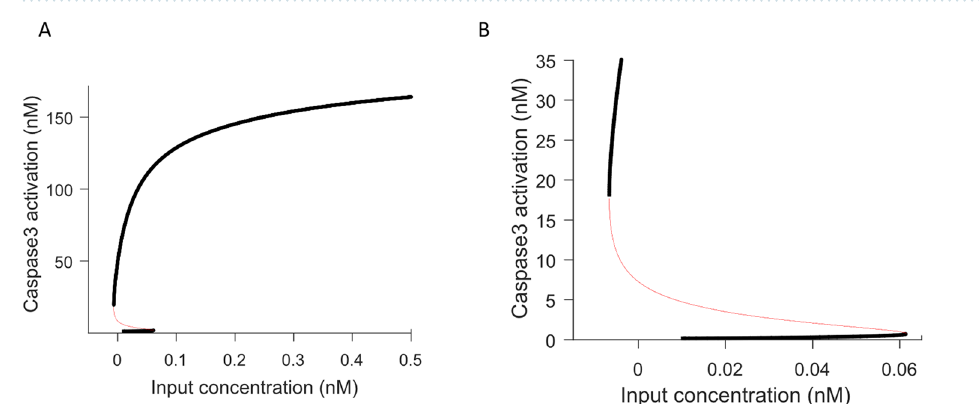
Figure 3. Bistable Behaviour of Caspase 3 activation. Steady state stimulus response bifurcation curve of caspase 3 activation. That simulated caspase 3(C3*) activation demonstrates irreversible bistability and hysteresis. ( A ). Three steady states are exhibited by the system, two stable (solid line) and one unstable (dashed line). The system can reside in one of the two stable steady states (‘on’ or ‘off’) but not in the intermediate unstable steady state. ( B ). The first bifurcation point at 0.06 and the second at − 0.01 indicates that the system displays hysteresis between stimulus concentration ( u ) 0–0.06 nM. The system remains at low caspase 3 activity (‘off’ state) for increasing stimuli until a threshold of u (0.06 nM) is reached, at which point caspase 3 activity switches to the second steady state (‘on’ state) irreversibly, in an all-or-none